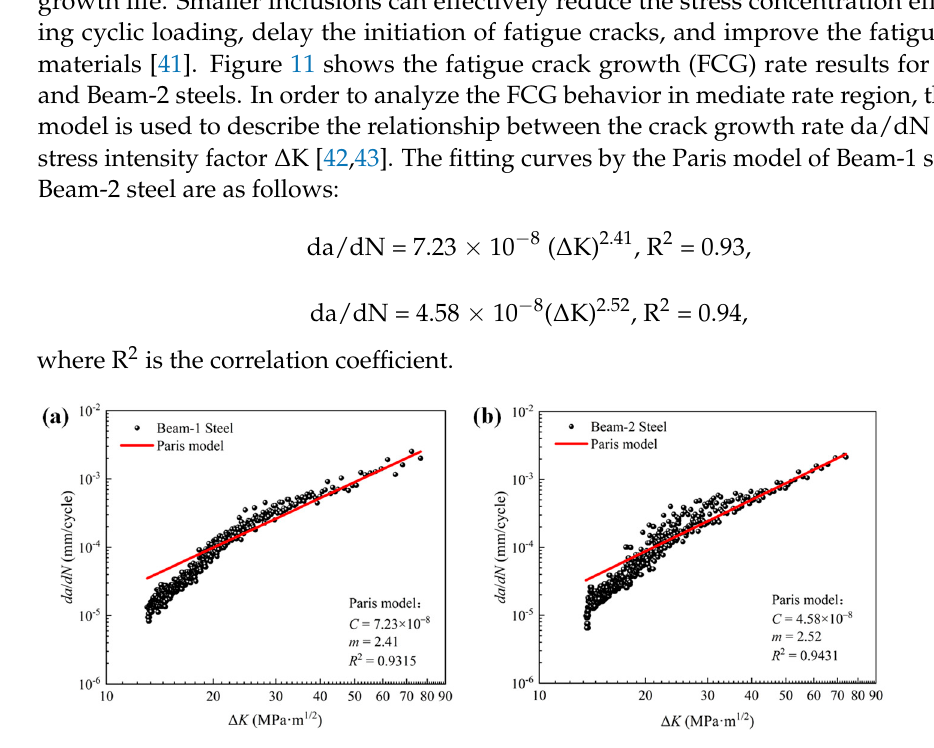
Figure 11. FCG experimental results and Paris model fitting results, ( a ) Beam-1 steel, ( b ) Beam-2